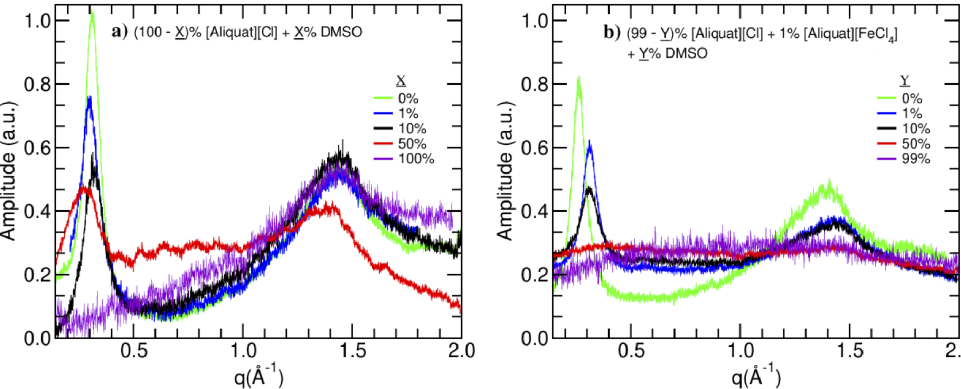
Figure 2. X-ray diffractometry profiles obtained for the non-magnetic ( a ) and magnetic ( b )